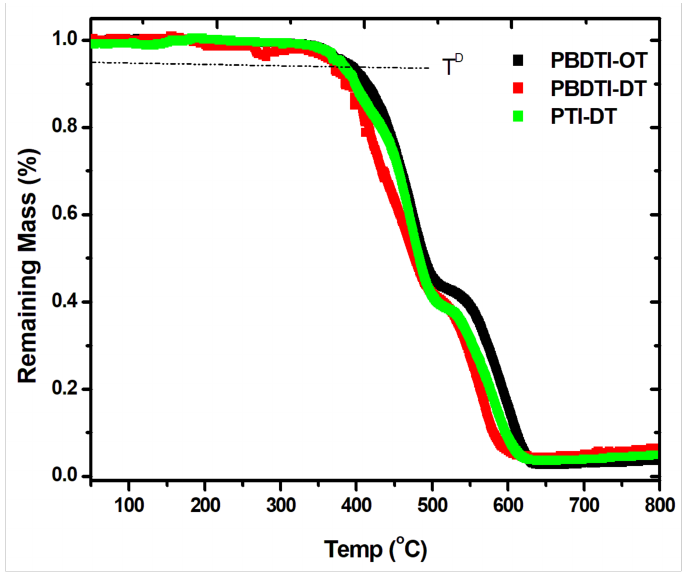
Figure 5. TGA measurement of PBDTI-OT (black), PBDTI-DT (red) and PTI-DT